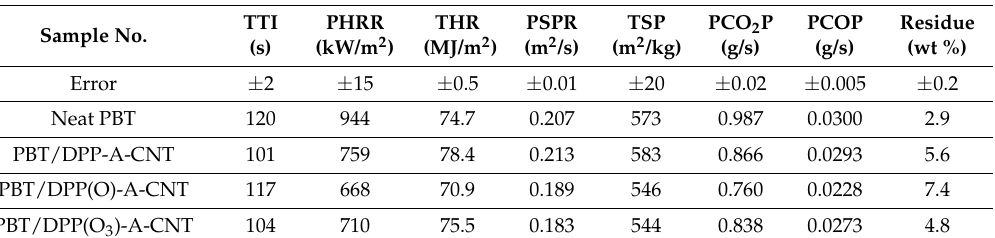
Table 4. Cone calorimeter data for each sample at 35 kW/m 2 . (TTI: time to ignition; PHRR: peak heat release rate; THR: total heat release; PSPR: peak smoke production rate; TSP: total smoke production; PCO 2 P: peak CO 2 production; PCOP: peak CO production).